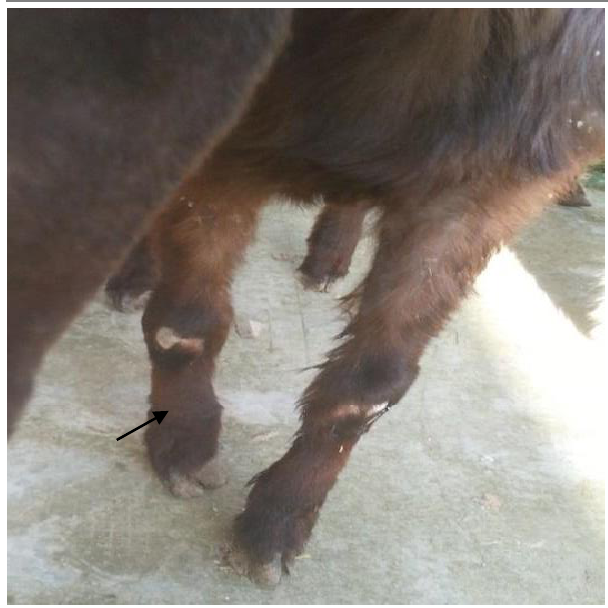
Figure 4. Goat on the 10 th week (end of the study) shows fissures and deformity of the